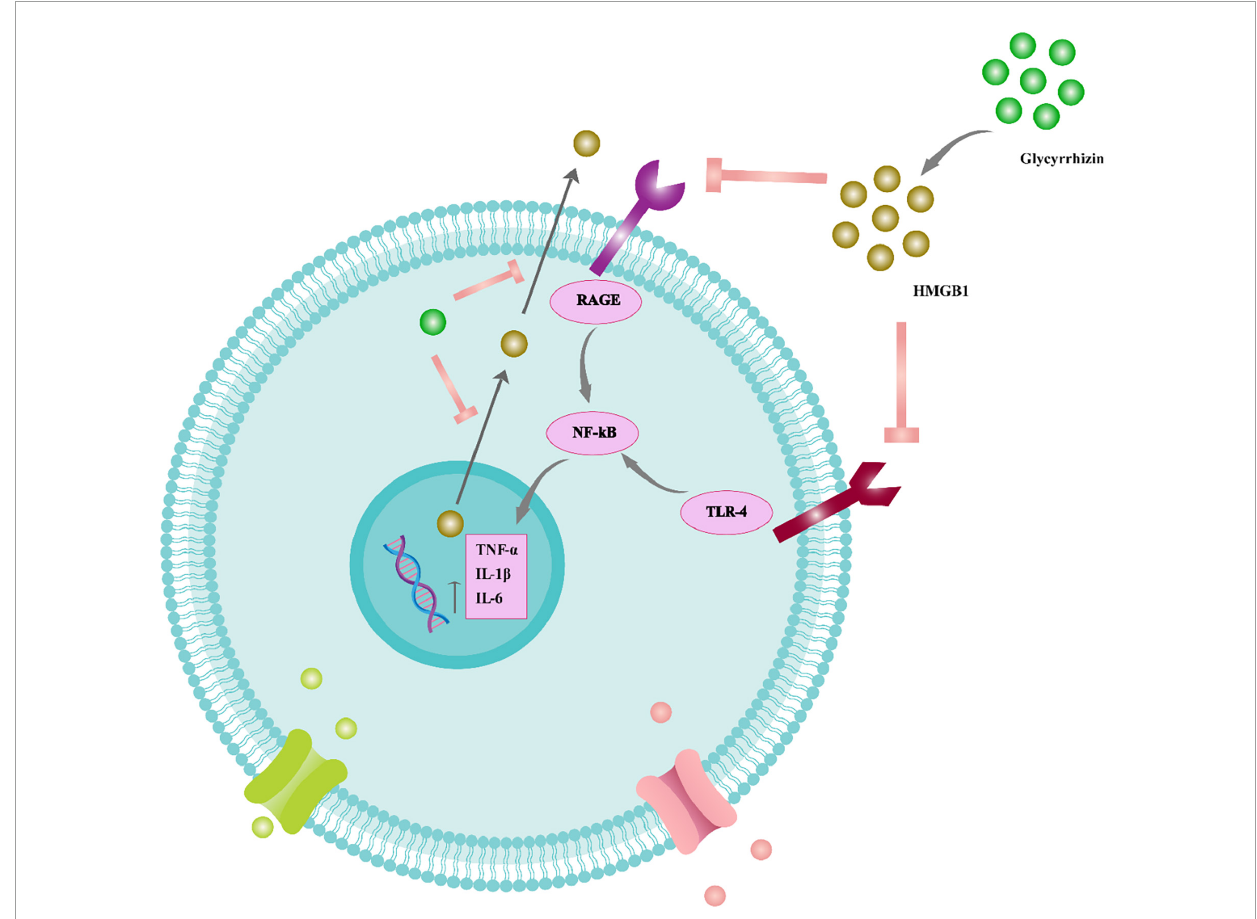
FIGURE4 The function of glycyrrhizin in the inflammatory cascade of the neural system. Glycyrrhizin binds to HMGB1 and prevents HMGB1/RAGE and HMGB1/TLR4 interaction. Therefore, NF-B signaling is suppressed and pro-inflammatory cytokines such as TNF-, IL-6, and IL-1 are reduced. Furthermore, glycyrrhizin prevents nuclear translocation of HMGB1 to the cytoplasm and consequent extracellular release, thus also reducing HMGB1’s extracellular pro-inflammatory actions. Tumor necrosis factor (TNF), receptor for advanced glycation end products (RAGE), interleukin (IL), nuclear factor light chain enhancer of activated B cells (NF-B), toll-like receptor 4